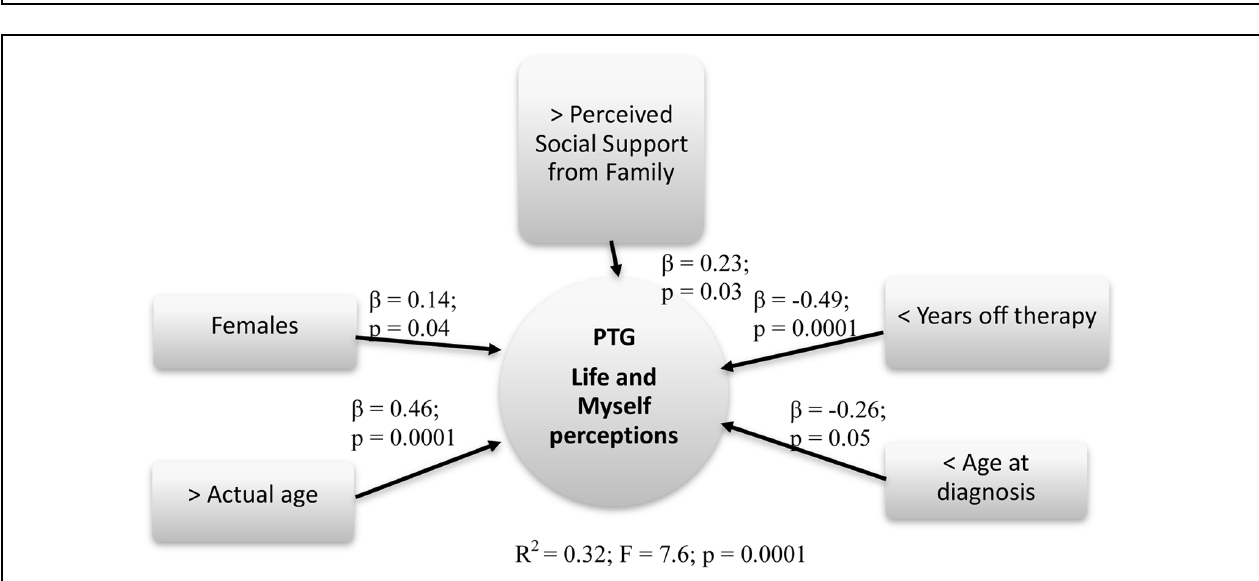
FIGURE 3 | Predictive factors of PTG global score. Rectangle: stable Independent variables; Circle: Dependent variables